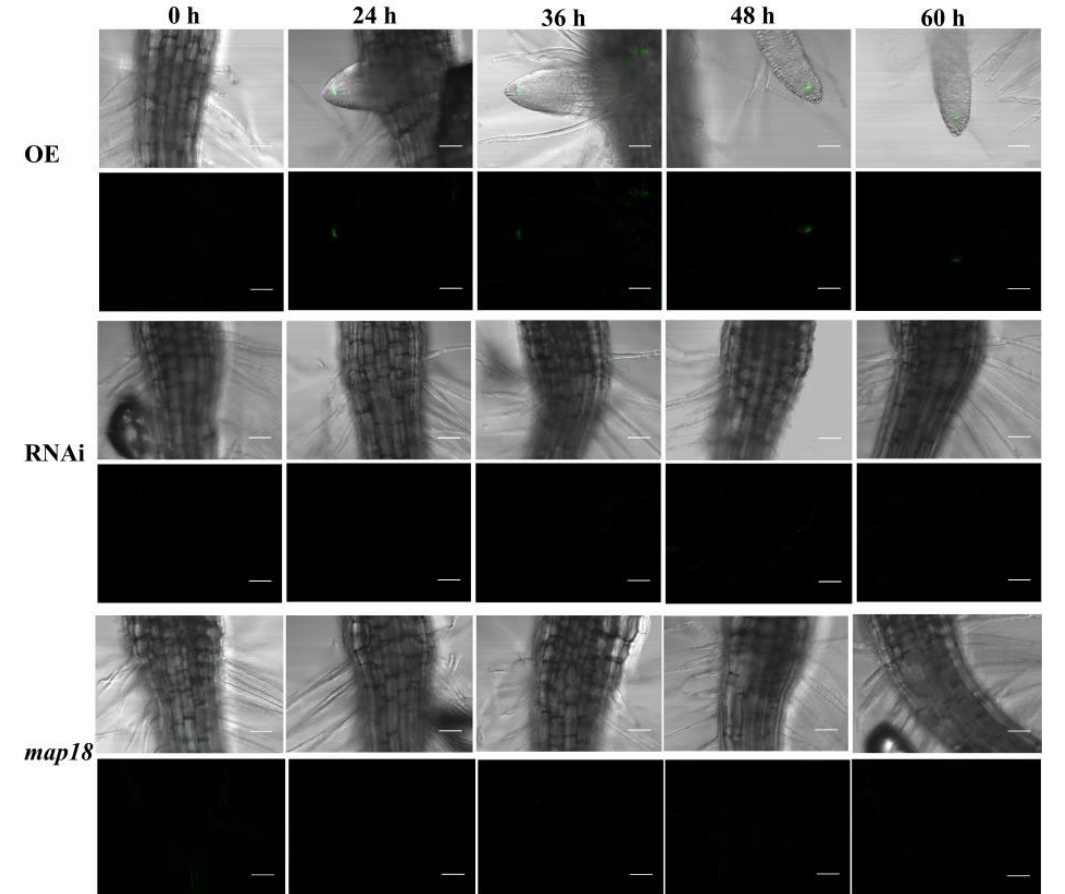
Figure A6. Effects of MAP18 on regenerated fix root and quiescent center cells of 7-day-old A. thaliana by UV-B radiation. Scale bars represent 60 μm.